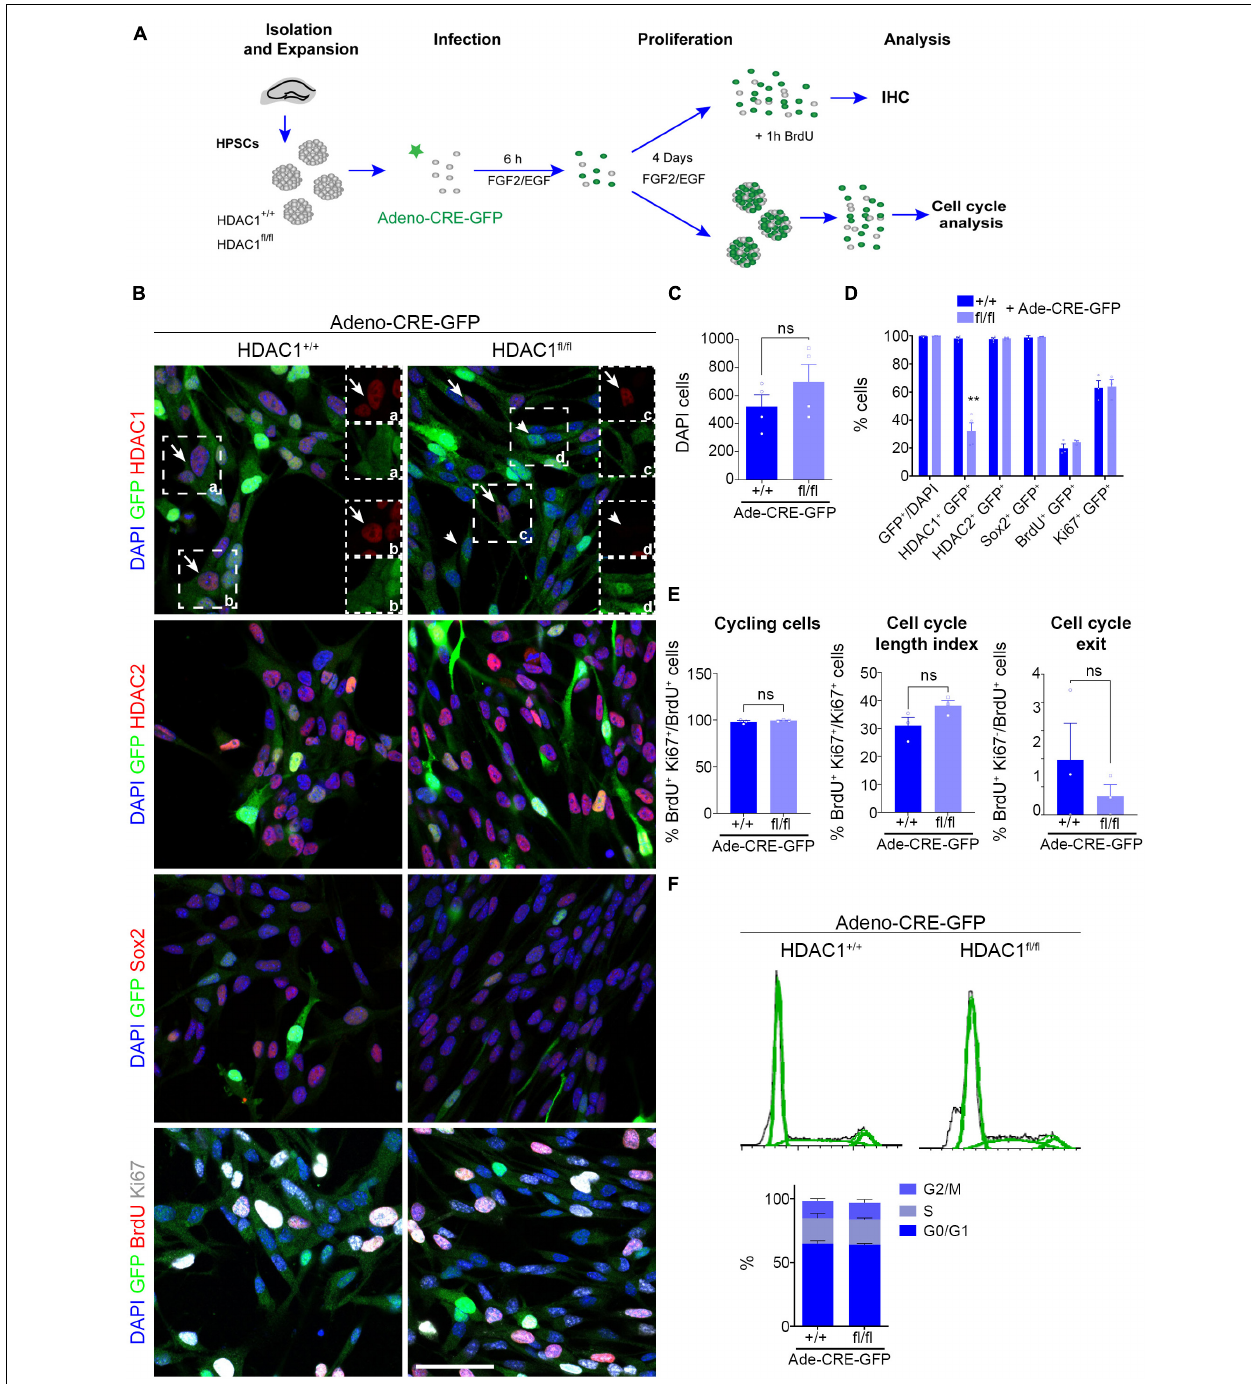
FIGURE 2 | HDAC1 deletion does not affect HPSC proliferation in vitro . (A) Experimental design of expansion, infection and maintenance of HPSCs in proliferation condition. After infection cells were kept in proliferation condition (plus EGF and FGF2) for 4 days attached to coverslips for immunostaining analysis or as neurospheres for cell cycle analysis by flow cytometry. (B) Representative images of HDAC1 + / + and HDAC1 fl / fl HPSCs infected with adeno-Cre-virus immunostained against GFP, HDAC1, HDAC2, Sox2, BrdU and Ki67, and stained with DAPI. (C) The graph shows the number of DAPI cells in 10 random fields in HDAC1 + / + and HDAC1 fl / fl cells infected with an adeno-Cre-GFP virus. (D) The graph shows the percentage of GFP + cells out of the DAPI cells and the percentage of GFP + cells expressing HDAC1, HDAC2, Sox2, BrdU and Ki67. (E) The graphs show the percentage of cycling cells (BrdU + Ki67 + /BrdU + cells), cell cycle length index (BrdU + Ki67 + /Ki67 + cells) and the percentage of cell cycle exit (BrdU + Ki67 − /BrdU + cells). (F) The graphs show representative cell cycle profiles from HDAC1 + / + and HDAC1 fl / fl cells infected with an adeno-Cre virus and percentage of cells in each phase of the cell cycle. Arrows point out HDAC1 + cells and arrowheads HDAC1 − cells. ** p < 0.01, ns = not significant. N = 4. Scale bar = 50.